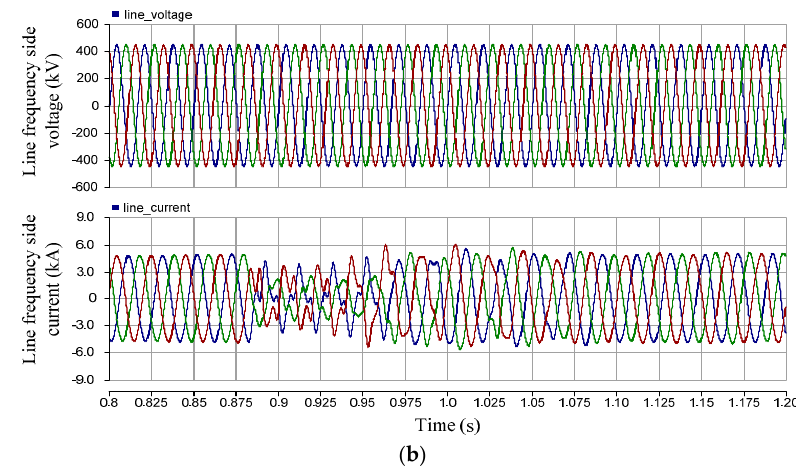
Figure 18. Simulation result of two ‐ phase LFAC transmission system of power reversal: ( a ) Low frequency side (10 Hz); ( b ) Line frequency side (60 Hz).